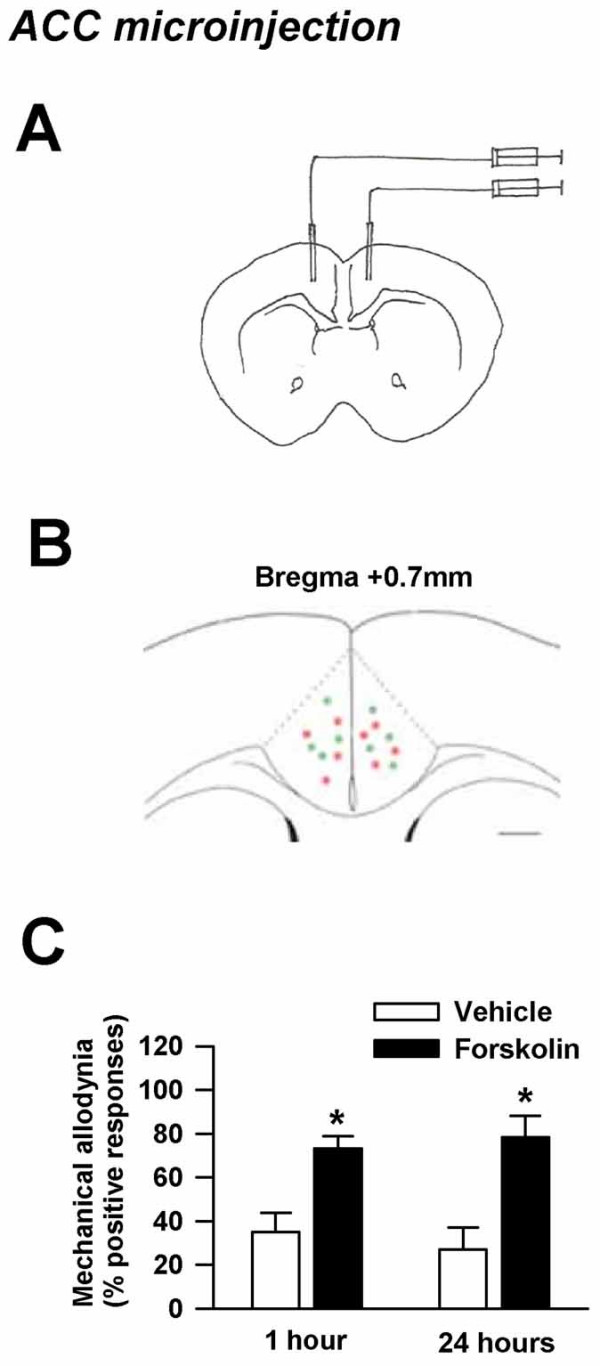
Rescue of mechanical allodynia by bilateral injection of forskolin into the ACC. A. Site of bilateral injection of forskolin into the ACC in coronal plane. Injections were made at 0.7 mm anterior to the bregma, 0.3 mm lateral to the midline and 1.75 mm ventral to the skull. B. Bilateral ACC microinjection sites of vehicle (in green) and forskolin (in red). The coronal section is 0.7 mm anterior to the bregma. C. Forskolin rescued behavioral allodynia in carrageenan induced chronic muscle pain in AC1&8 DKO mice on day 9 on the ipsilateral side. Forskolin injection, n = 6 mice; Vehicle injection, n = 5 mice. p < 0.05. *Significant difference from vehicle injection.